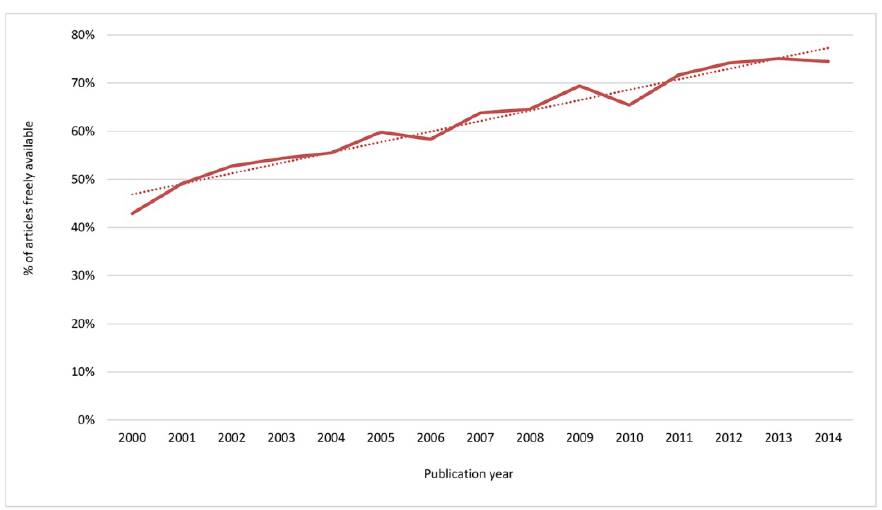
The dotted line shows the linear trend in availability over time.